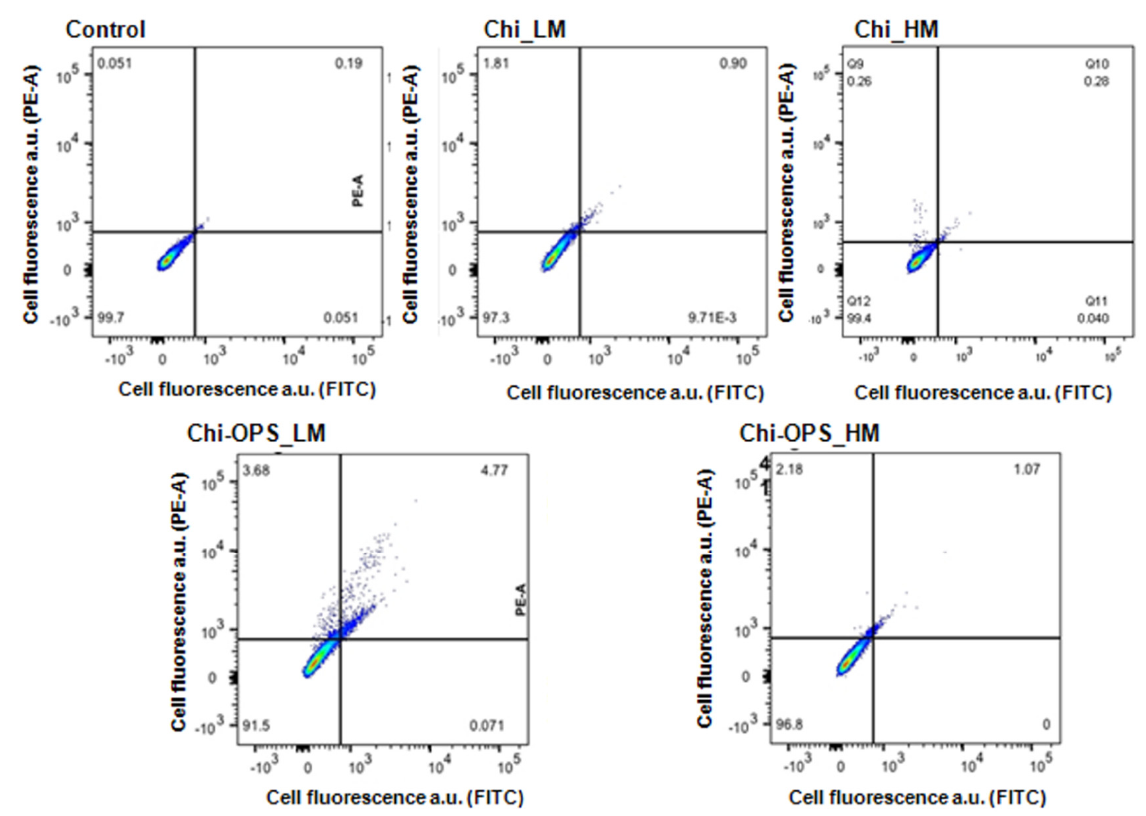
Figure 5. Quantitative flow cytometry study for live/dead assay using different QD conjugated nanoparticles on MG63 cells. FTIC for early apoptotic cells and PE-A for late apoptotic and dead cells.